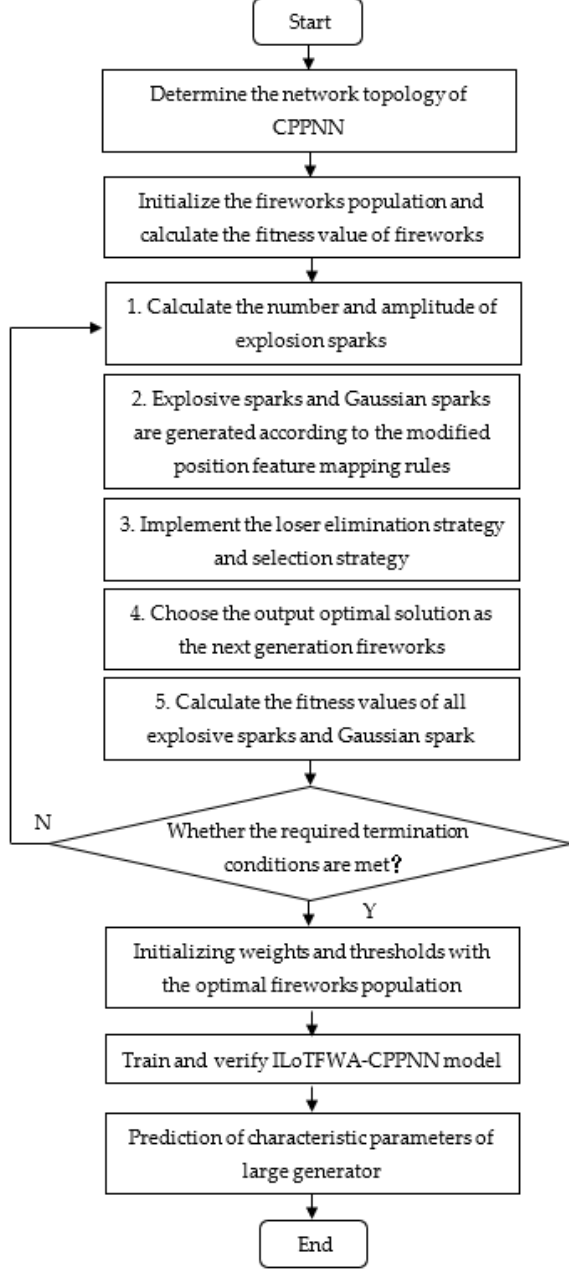
Figure 6. The flow chart of ILoTFWA ‐ CPPNN algorithm.